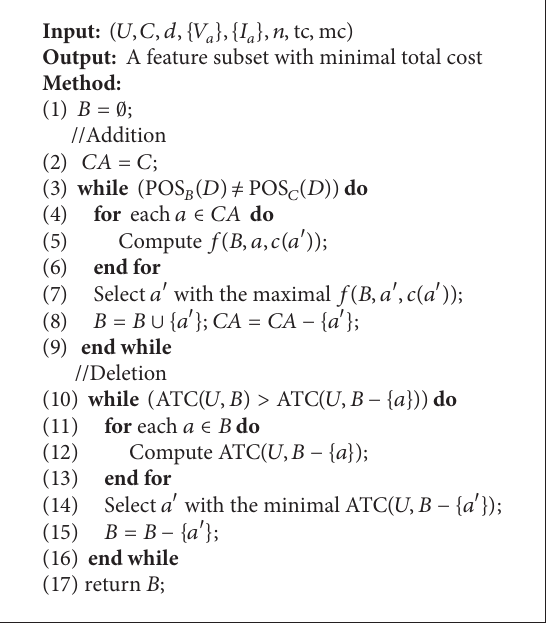
Algorithm 2: An addition-deletion cost-sensitive feature selection